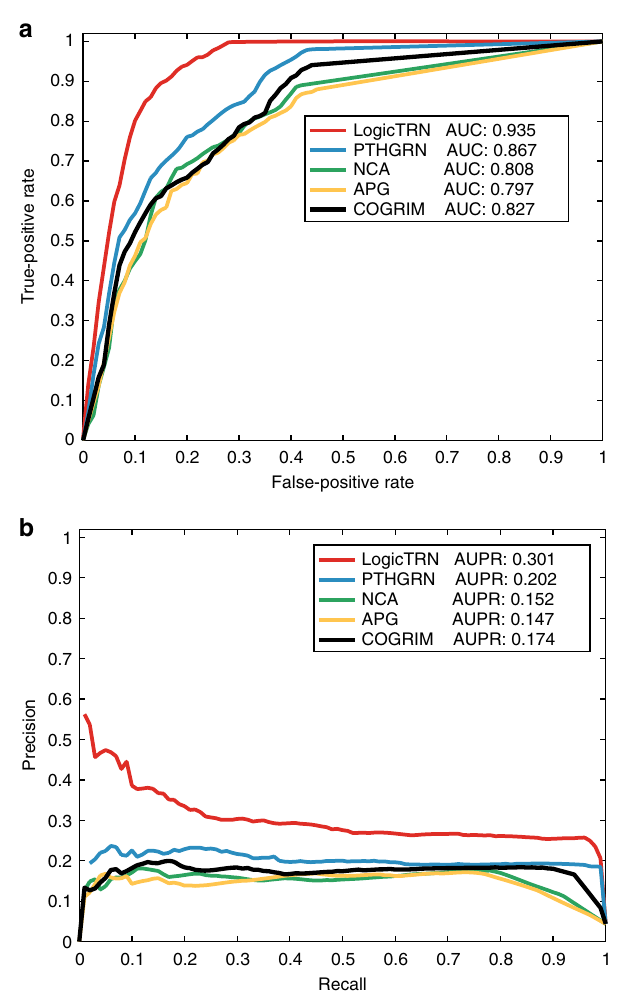
Fig. 3 Comparison of LogicTRN with COGRIM, APG, NCA, and PTHGRN in identifying target genes of mouse ESC TFs (Oct4/Pou5 fl , Sox2, Nanog, and Suz12). a ROC curves and their AUCs. b PR curves and their AUCs. To conduct ROC and PR analyses, a full set of positives and negatives